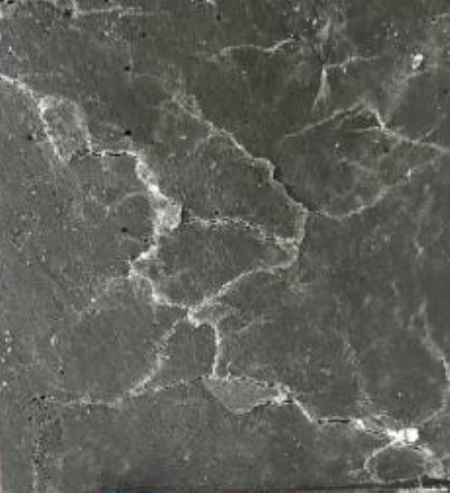
Figure 10. Macro-cracks of 28-day cube specimen destruction.